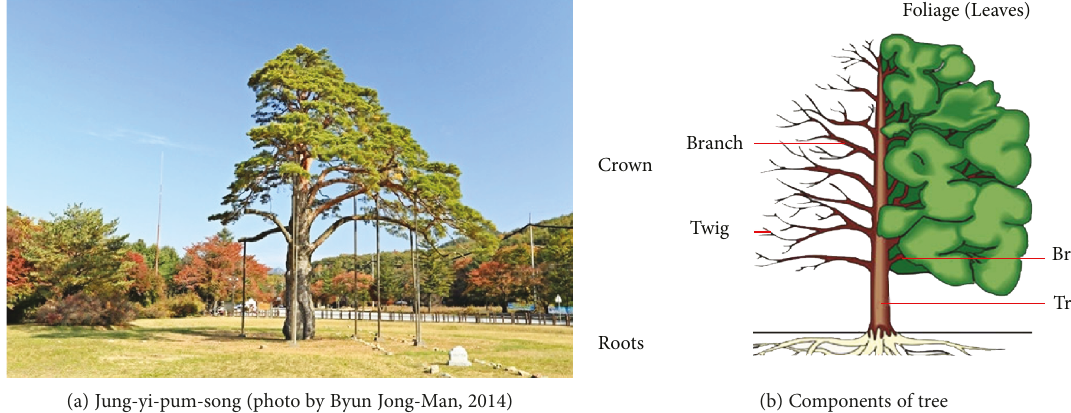
Figure 2: Jung-yi-pum-song (National Monument #103 in South Korea) and components of